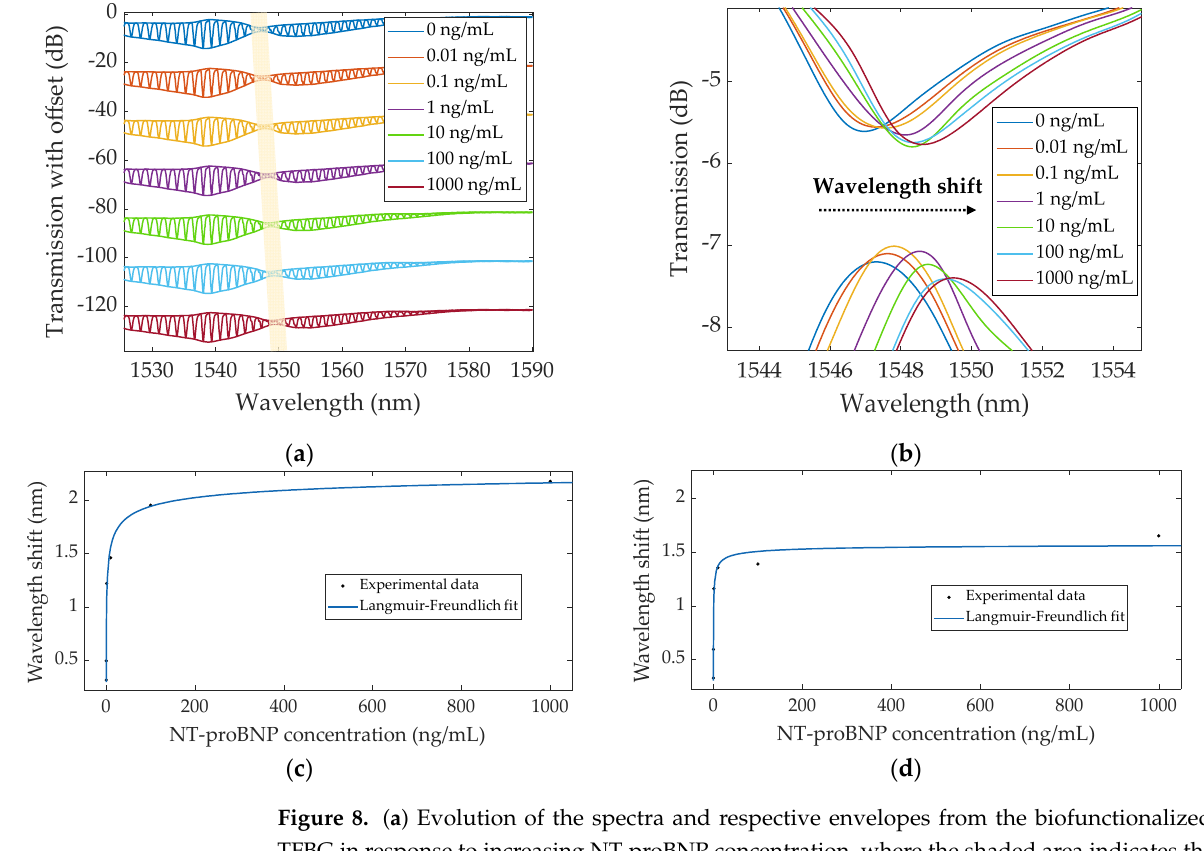
Figure 8. ( a ) Evolution of the spectra and respective envelopes from the biofunctionalized Au–TFBG in response to increasing NT-proBNP concentration, where the shaded area indicates the SPR signature; ( b ) Progression of the lower envelope maximum and upper envelope minimum; Plot of the wavelength shift of ( c ) lower and ( d ) upper envelopes, showing the Langmuir–Freundlich fitting.